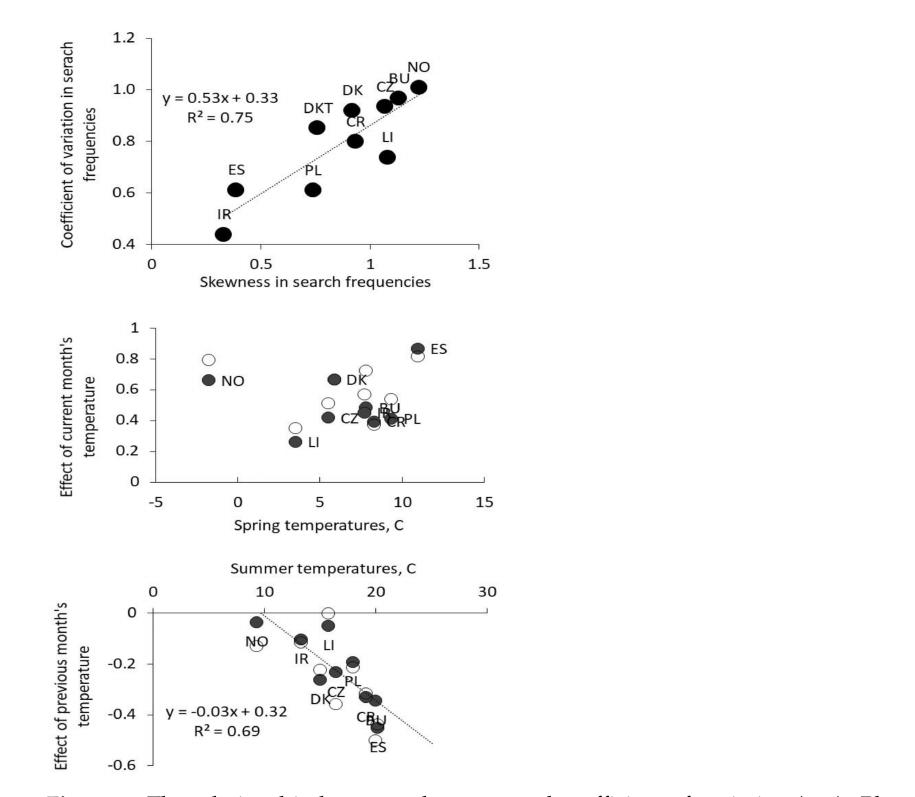
Figure 4. The relationship between skewness and coefficient of variation ( top ). Plot of estimates for the effect of temperatures in current month vs. mean temperature − 0.5 sd (spring tempera- ture: middle ) and plot of estimates for the effect of temperatures in previous month vs. mean temperature + 1 sd (summer temperature: below